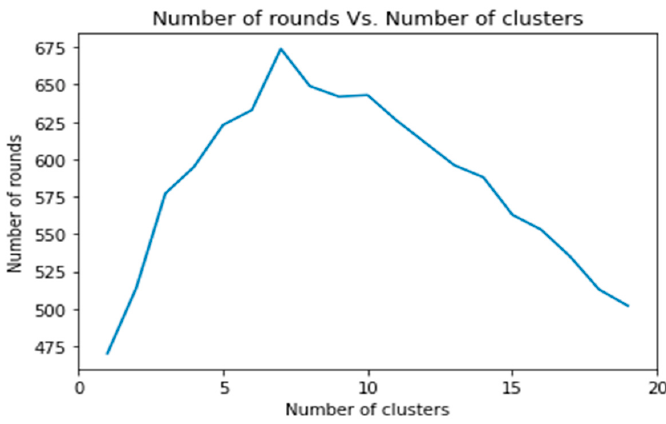
Figure 5. Optimal number of clusters in the network.